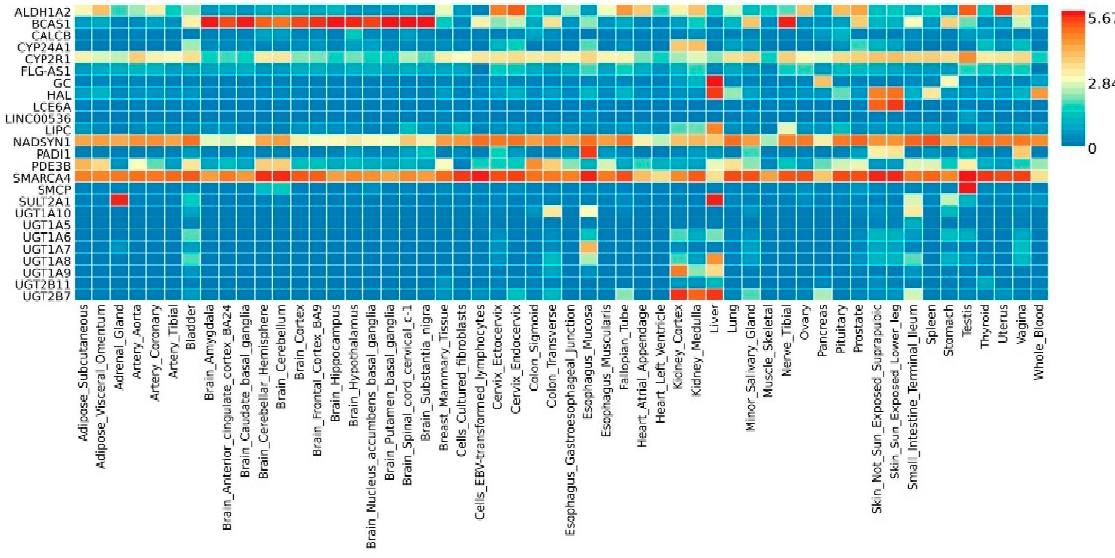
Figure 1. Heat map of the VD deficiency gene expression in different tissues. The tissue-specific expression patterns are based on GTEx v6 RNA − seq data. Cells in red represent a higher expression, compared to the cells in blue. Gene expression comparisons between tissues (horizontal comparison) within a gene (y axis) are comparable but not those of different genes within a tissue (vertical comparison). Thus, cells in red represent a higher expression of genes in a corresponding tissue, compared to other tissues, but do not represent a higher expression, compared to other genes. Source: FUMA .